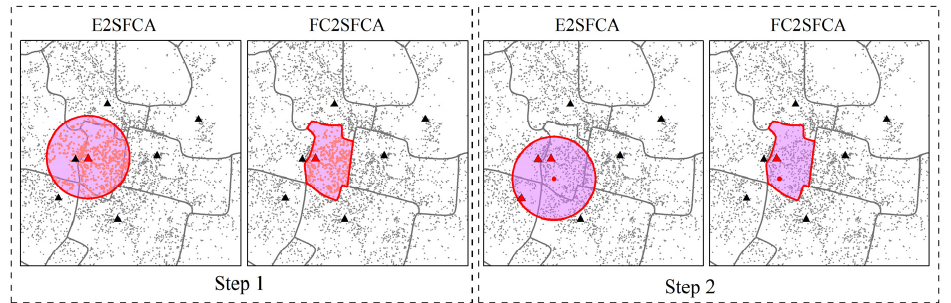
Figure 4. Comparison of E2SFCA and FC2SFCA for generating the catchment area.